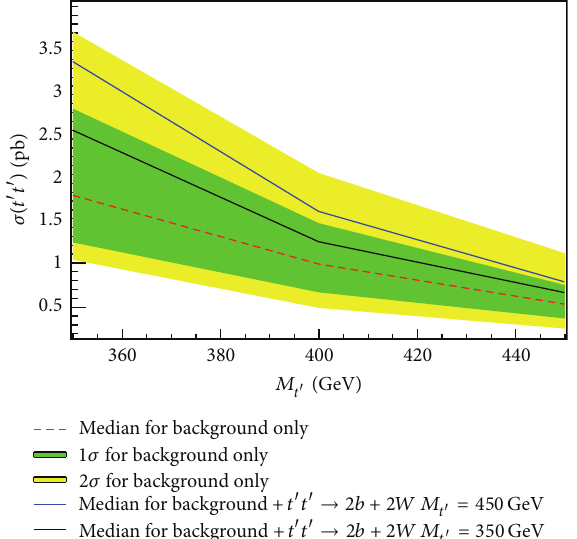
Figure 20: The 95% CL exclusion plot distribution on the 𝑡 󸀠 mass assuming the SM4 signature in the semileptonic channel ( 1ℓ + 𝑛𝑗 + (cid:2)(cid:2) 𝐸 𝑇 ). For the case of background only, the red dotted line is the median and the yellow and green bands are the ±1 and ±2 standard deviations accordingly. The black line is the median for background + 𝑡 󸀠 𝑡 󸀠 → 2𝑏 + 6𝑊 with 𝑚 𝑡 󸀠 = 450 GeV and the blue line is the median for background + 𝑡 󸀠 𝑡 󸀠 → 6𝑏 + 2𝑊 with 𝑚 𝑡 󸀠 = 350 GeV. The curves for the 4G2HDMI signatures with 𝑚 𝑡 󸀠 = 350–450 GeV lie between these two lines. Figure taken from [149].